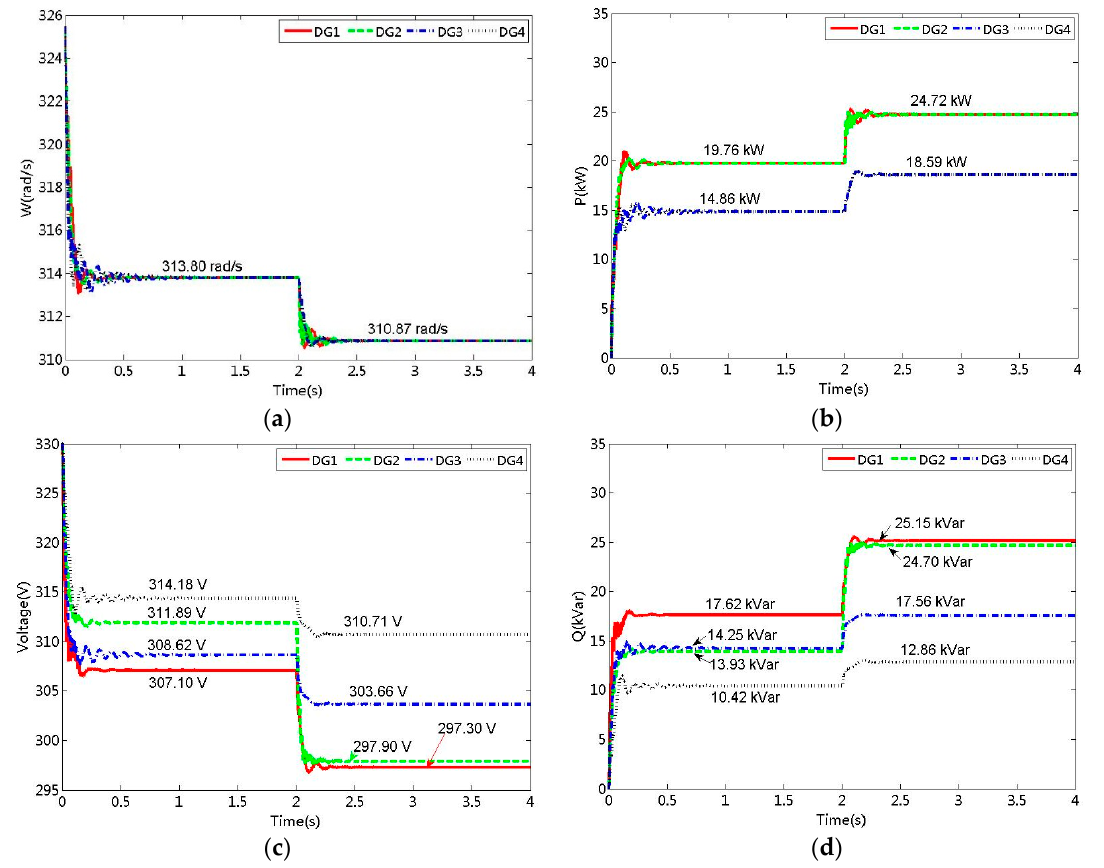
Figure 10. Simulation results with the traditional droop control. ( a ) Frequency; ( b ) active power of each DG; ( c ) voltage; ( d ) reactive power of each DG.